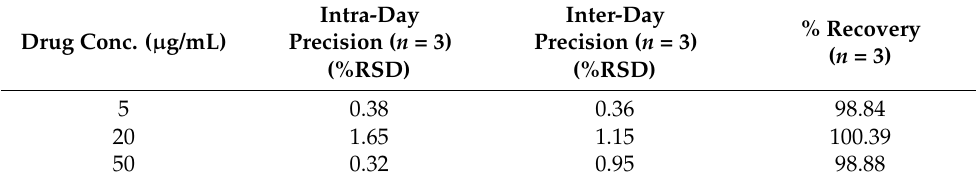
Table 1. Intra-day, inter-day, and % recovery studies.